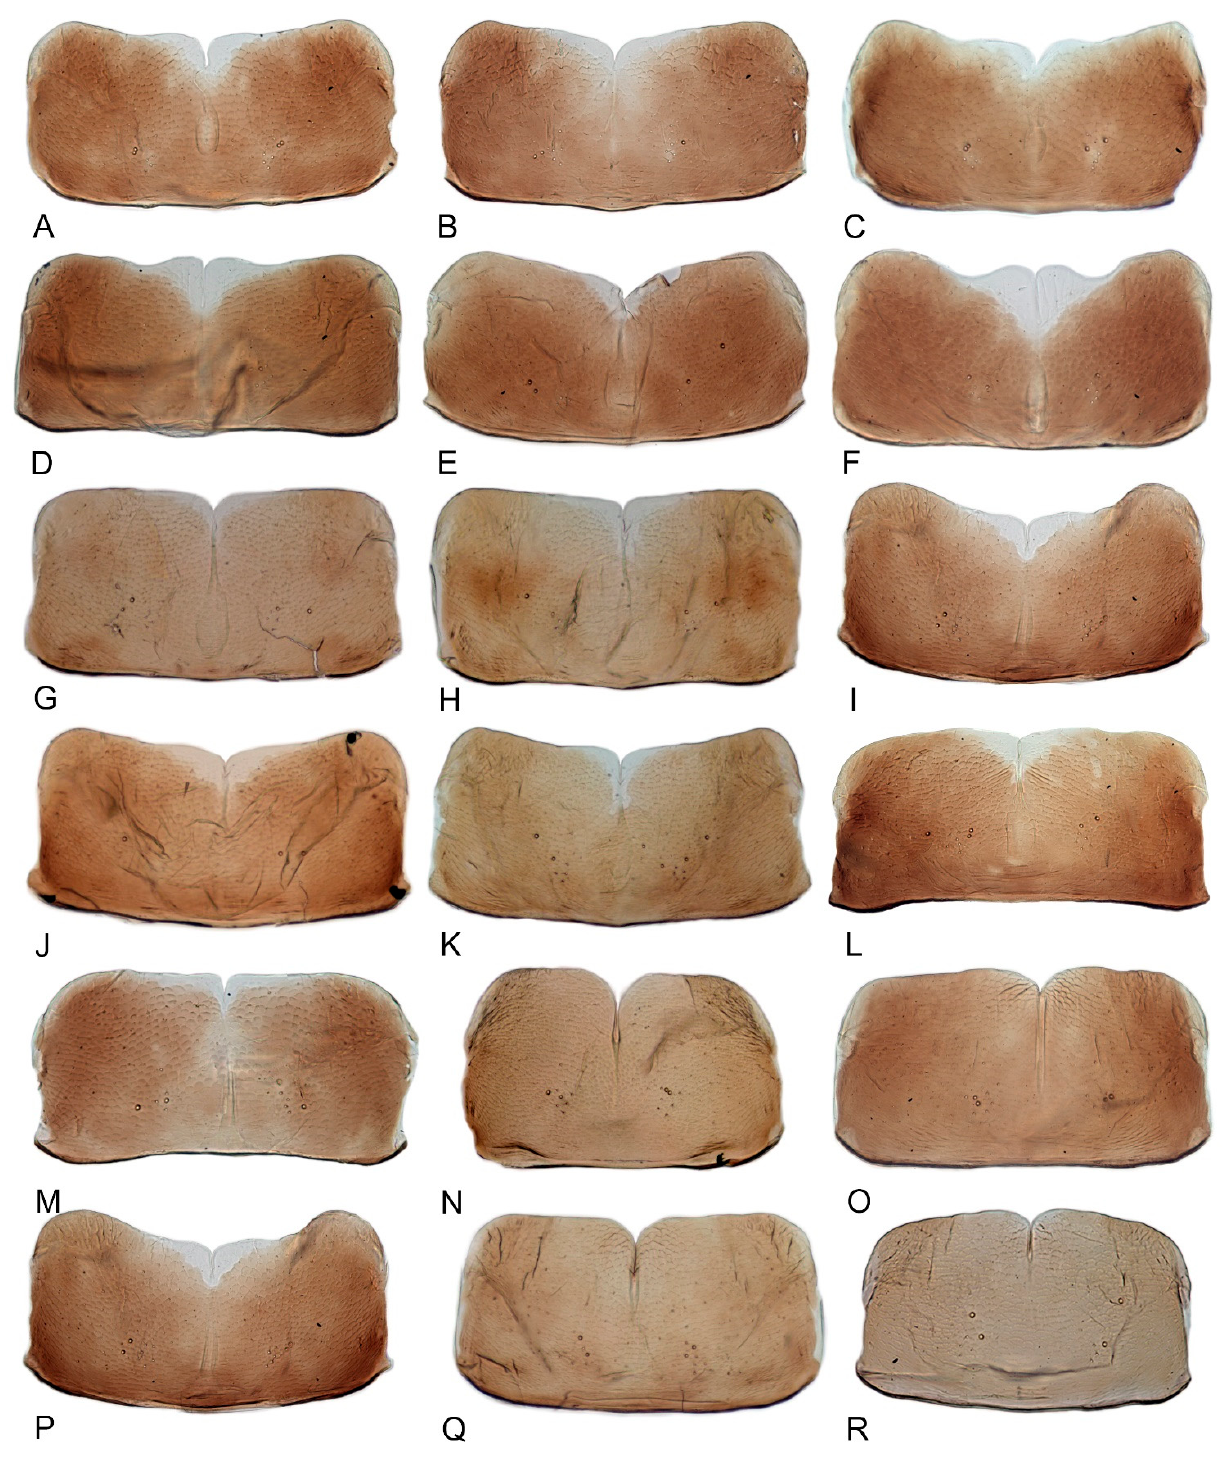
Figure 24. Female sternite VII, ventral view. ( A ) X. asper ; ( B ) X. guttulatus ; ( C ) X. ishidae ; ( D – F ) X. nonattribus sp. nov.; ( G ) X. binarius sp. nov.; ( H ) X. densprint sp. nov.; ( I ) X. toroensis ; ( J ) X. chrysanthemum sp. nov.; ( K ) X. tenusis sp. nov.; ( L ) X. exproiecturus sp. nov.; ( M ) X. abyssinicus ; ( N ) X. cowboyocreus sp. nov.; ( O ) X. recipinams sp. nov.; ( P ) X. limpidissimus sp. nov.; ( Q ) X. dimiprocessus sp. nov.; ( R ) X. malleus sp. nov.